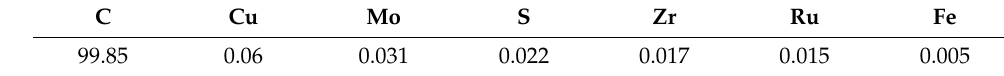
Table 1. XRF analysis of the liberated graphite electrode material (Wt. %).